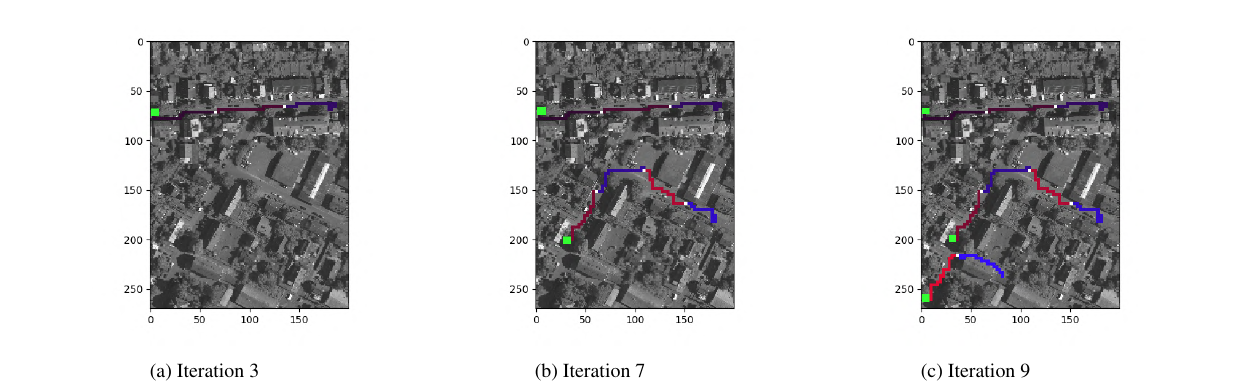
Figure 6. Hybrid approach on the training image. The starting seeds are highlighted in green (root seeds) and in white (last positions seed). The trajectories generated by the RL-agent at each iteration are highlighted with different colors.